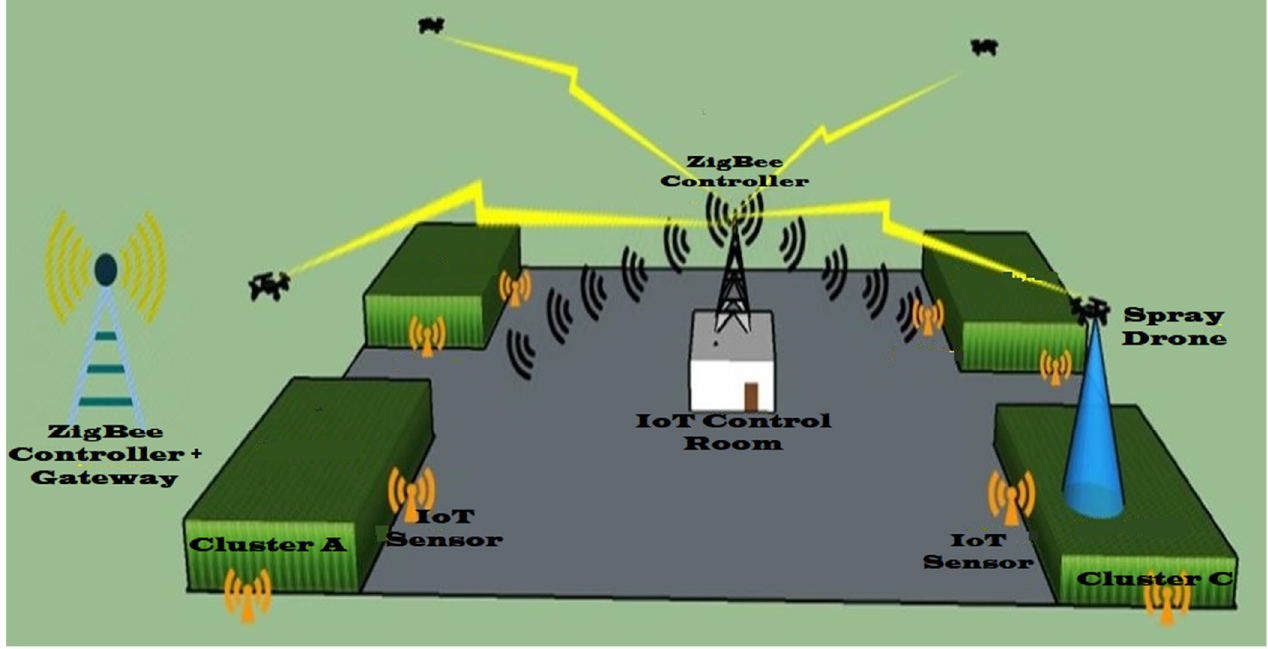
Figure 5. Pest Detection and Response system architecture.